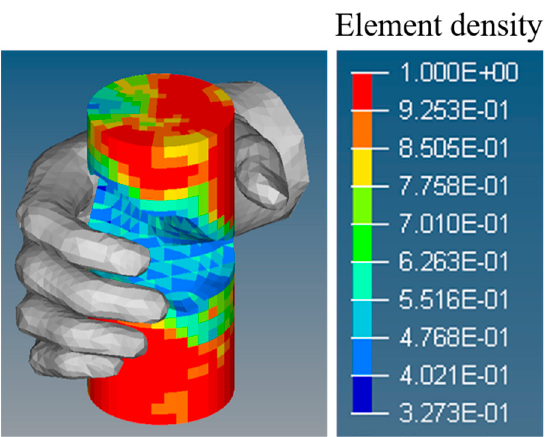
Figure 15. Column FE model with an element density ( − ) of 0.5 or above (elements with element density of below 0.5 are removed). The hand model is in the initial posture.